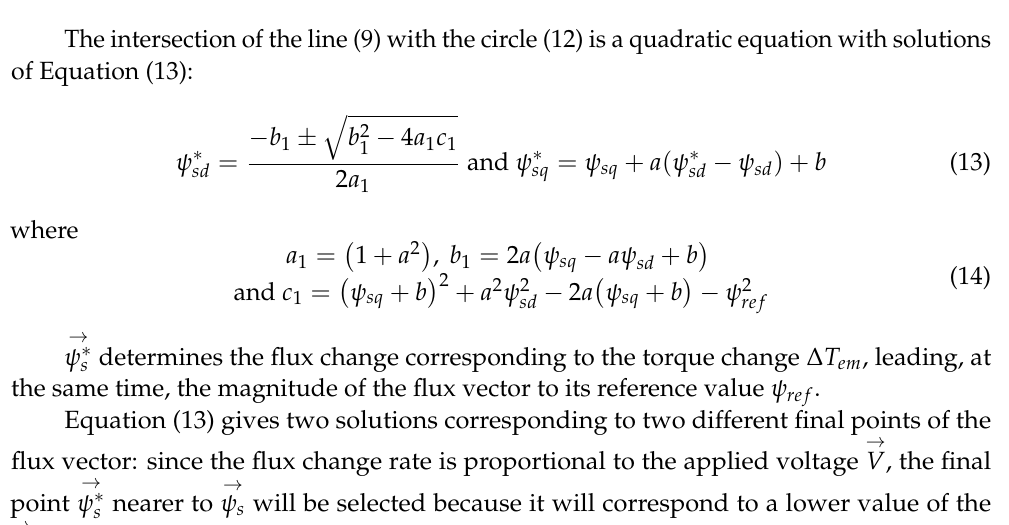
→ ψ ∗ s corresponding to the torque change ∆ T em